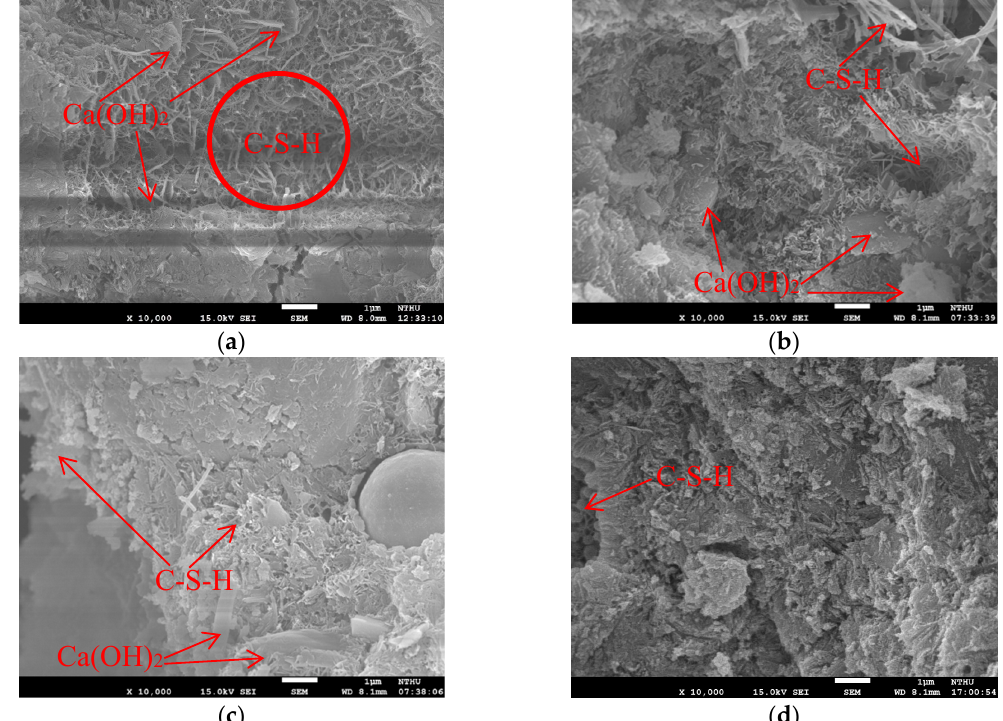
Figure 9. SEM photos at 28 days: ( a ) P; ( b ) S40; ( c ) S50 and ( d ) S60.